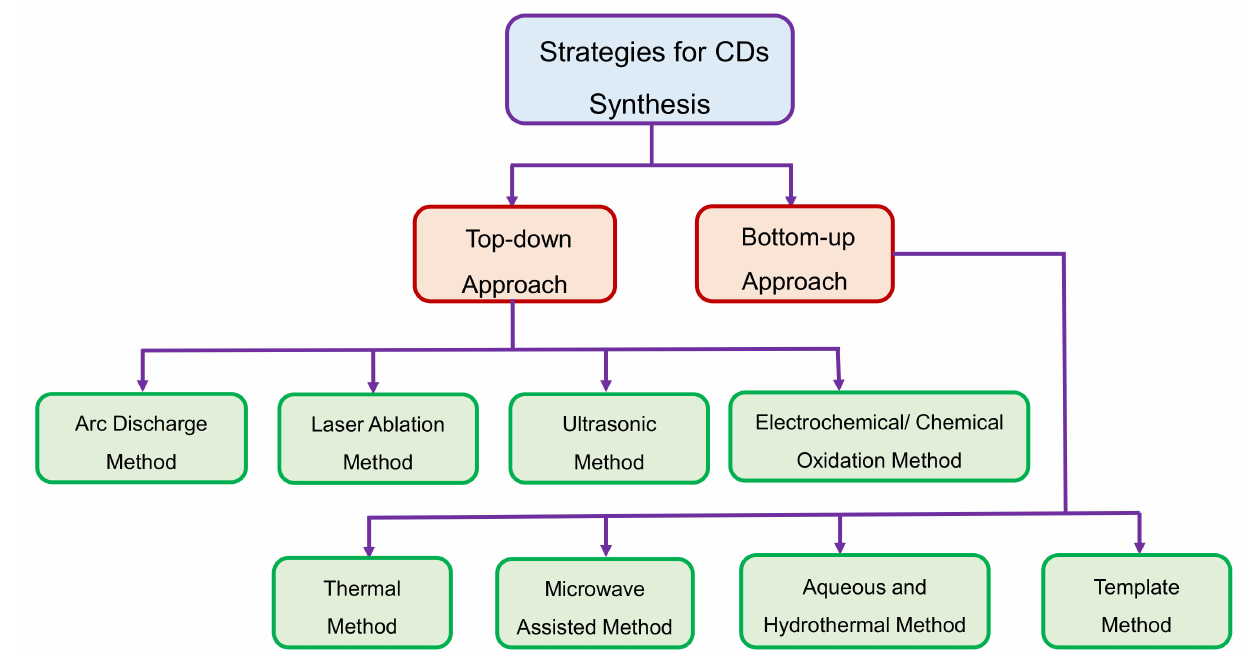
Figure 3. Approaches to synthesize CDs. Adapted from [49], 2018, Galenos Publishing